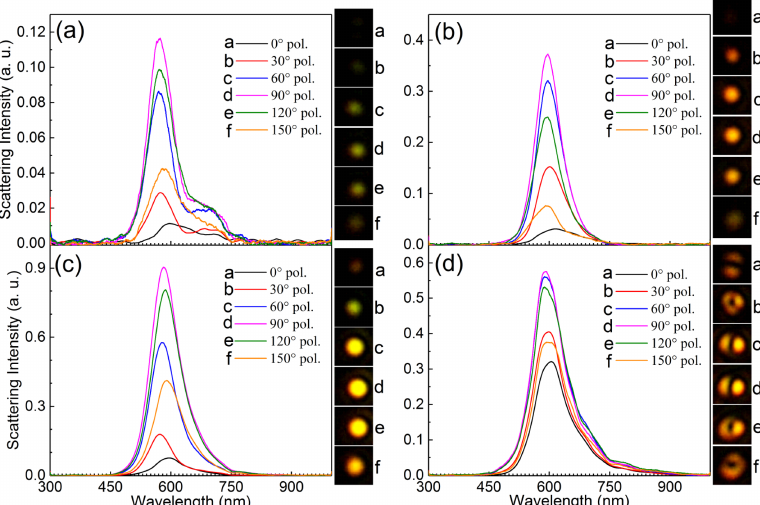
Figure 6. Polarization-resolved scattering spectra measured for Ga NPs with different diameters placed on the Au/SiO 2 substrate ( a ) d = 146 ± 2 nm, ( b ) d = 165 ± 2 nm, ( c ) d = 281 ± 2 nm and ( d ) d = 657 ± 2 nm. The corresponding radiation patterns are shown in the insets and the size of the optical images is 4 × 4 µ m 2